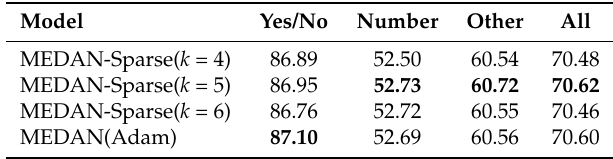
Table 4. Results of MEDAN and MEDAN-Sparse with different k ∈ {4, 5, 6} on VQA v2 test-dev set. The best results are